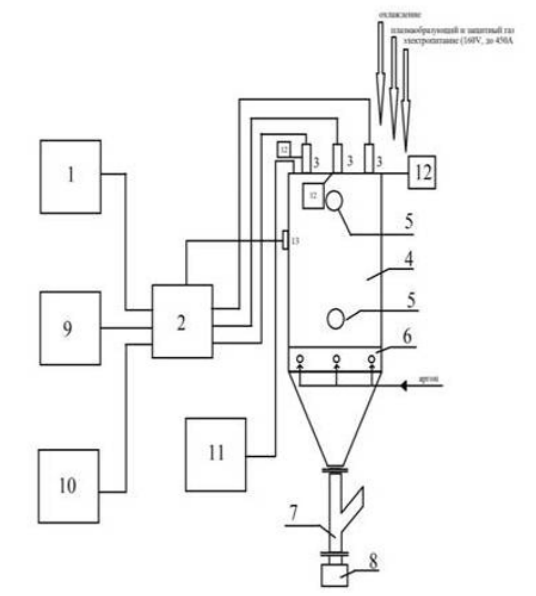
Fig. 1. Schematic circuit of a plasma atomizer: 1. Power supply, 2. Control and safety units, 3. Plasma torches (there is the layout of the atomizer with three spray units), 4. Spray column, 5. Peephole on the chamber side surface for visualizing the spray process, 6. "Fluidized bed" belt – a system of multidirectional injectors through which protective gas is supplied, 7. Plasma gas removal system during the spray process, 8. Powder collection system, 9. Gas system, 10. Plasma torch cooling system, 11. Column cooling system spraying, 12. Solid feedstock supply system, 13. Measuring equipment (control and safety